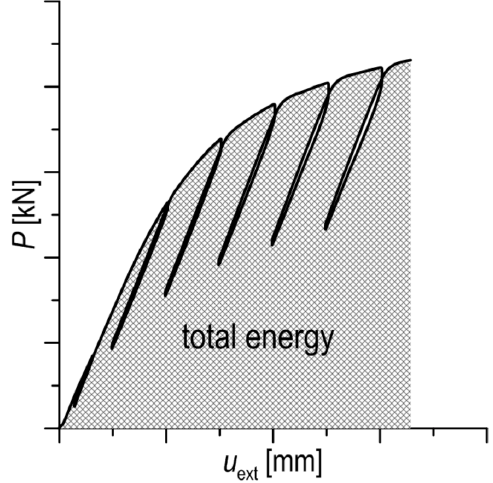
Figure 6. Scheme of fracture energy determination.